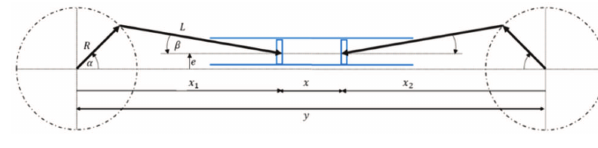
Fig. 6. DSOP engine